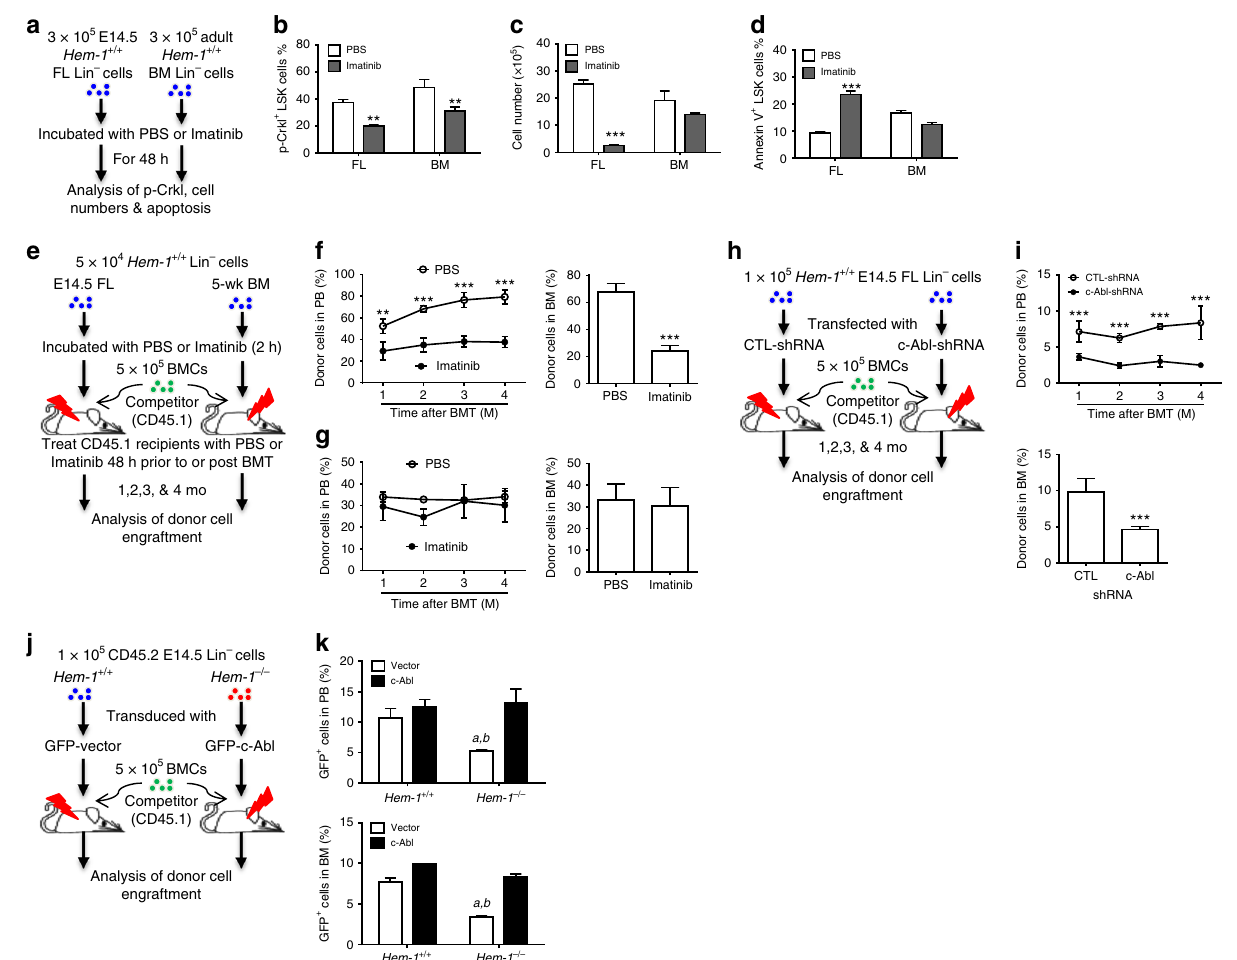
Fig. 6 c-Abl is essential for engraftment of FL HSCs after homing to marrow. a Schematic of imatinib treatment of 5-week-old adult Hem-1 + / + BM and E14.5 FL Lin − cells. b Imatinib treatment decreased phosphorylation of Crkl in both adult BM and FL Lin − cells ( n = 3, ** p < 0.01, two-way ANOVA). c